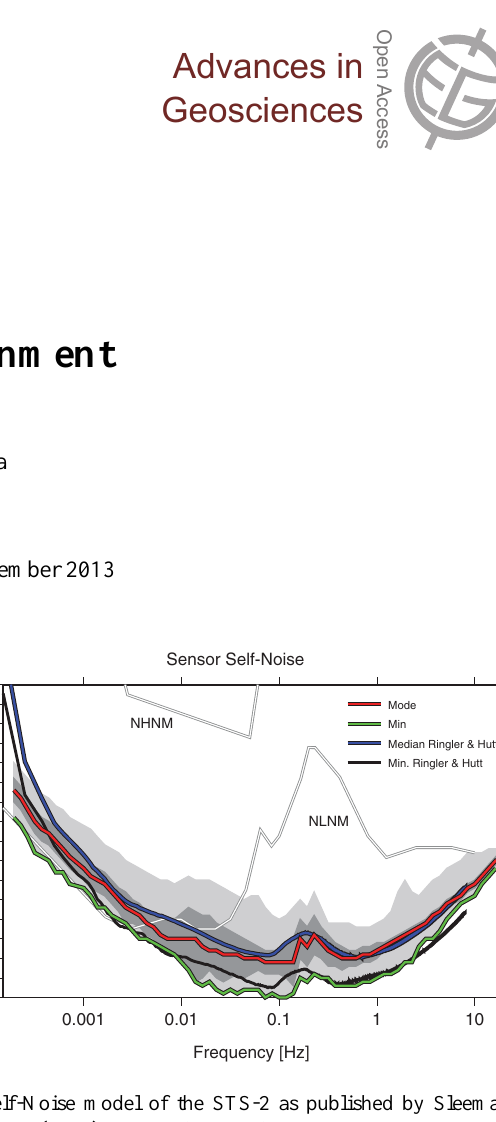
sources, then this procedure can be used to get an estimate of their